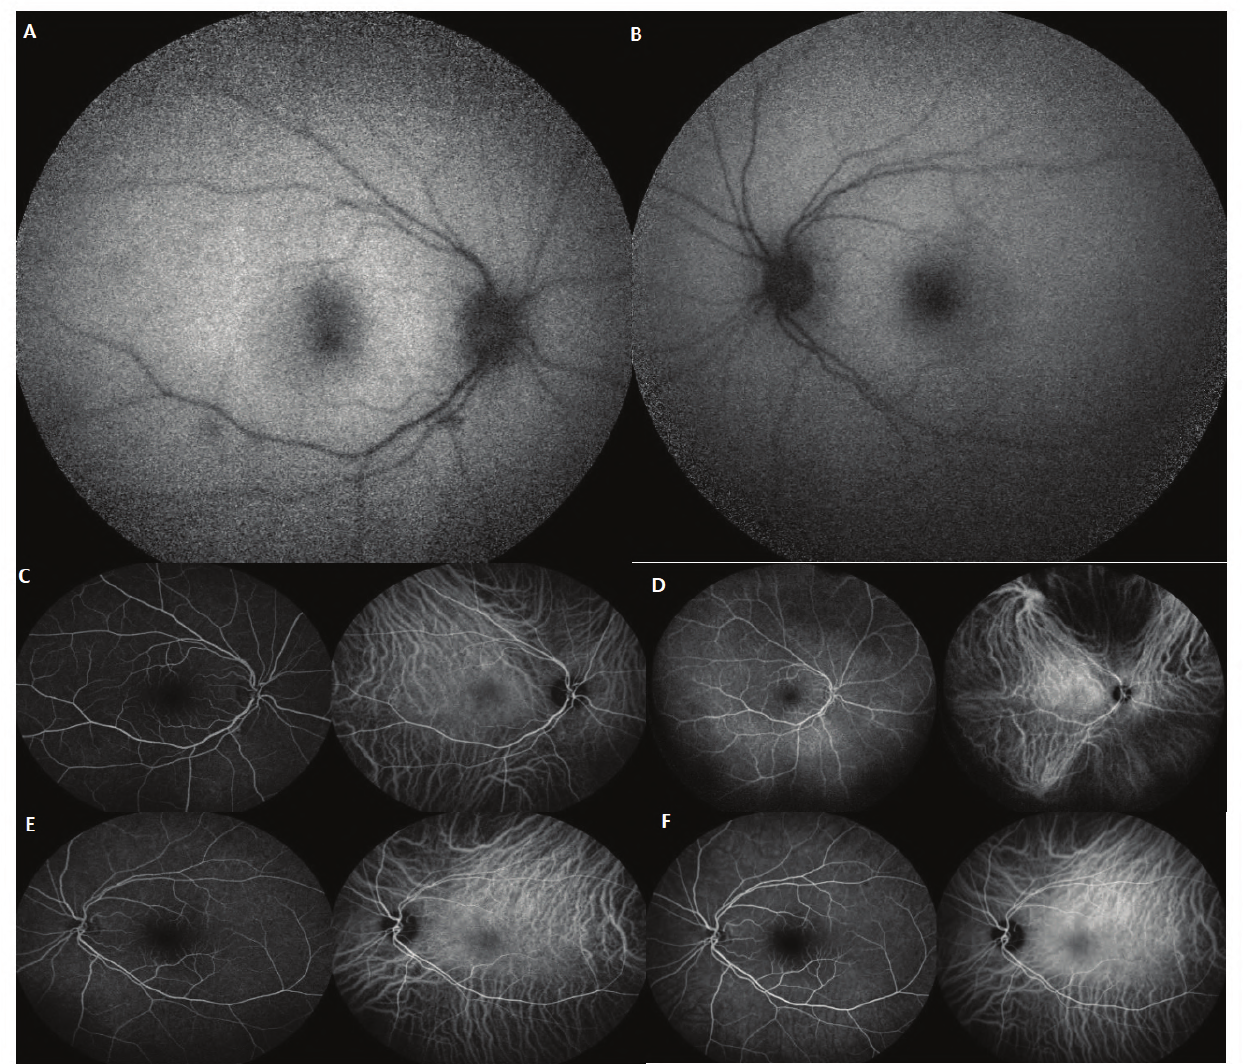
Figure 5. A and B illustrate fundus autofluorescence (FAF) of the right and left eyes, respectively. These images appear normal. C and D are early and late images of fluorescein angiography and indocyanine green angiography of the right eye, respectively. They are within the normal limit. E and F are early and late images of fluorescein angiography and indocyanine green angiography of the left eye, respectively. They are within the normal